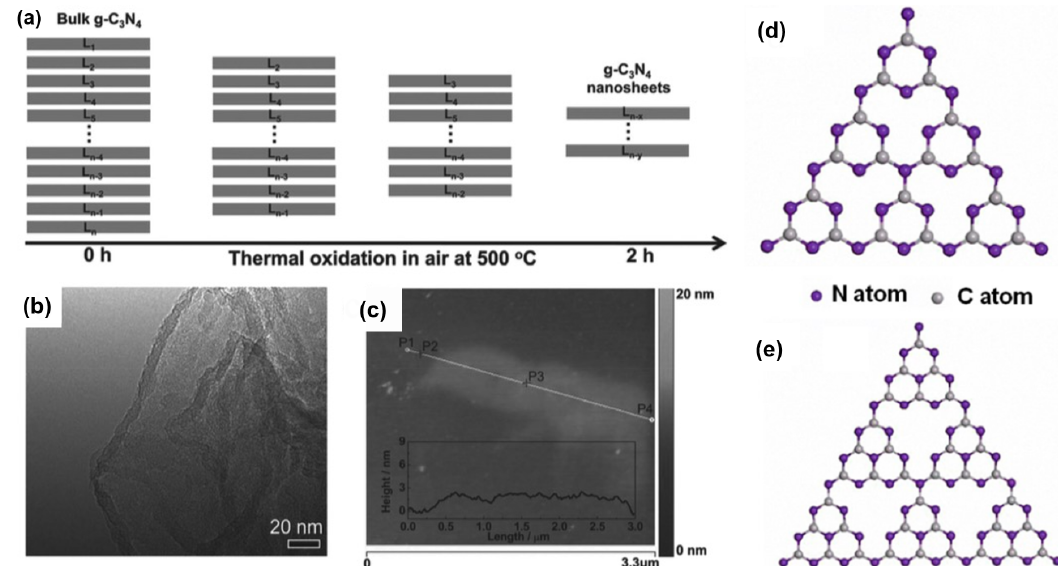
Figure 16. ( a ) Diagrammatic drawing of g -C 3 N 4 monolayer by a direct thermal oxidation etching process at 500 ◦ C. ( b ) TEM image and ( c ) AFM image of the g -C 3 N 4 monolayer, with the insert showing the height profile along the P1-P4 line. Reproduced with permission from reference [198]. Copyright 2008, Royal Society of Chemistry. Schematic structural illustration of ( d ) s -Triazine and ( e ) tri- s -triazine structures of g -C 3 N 4 monolayers, respectively. Reproduced with permission from reference [102]. Copyright 2015,